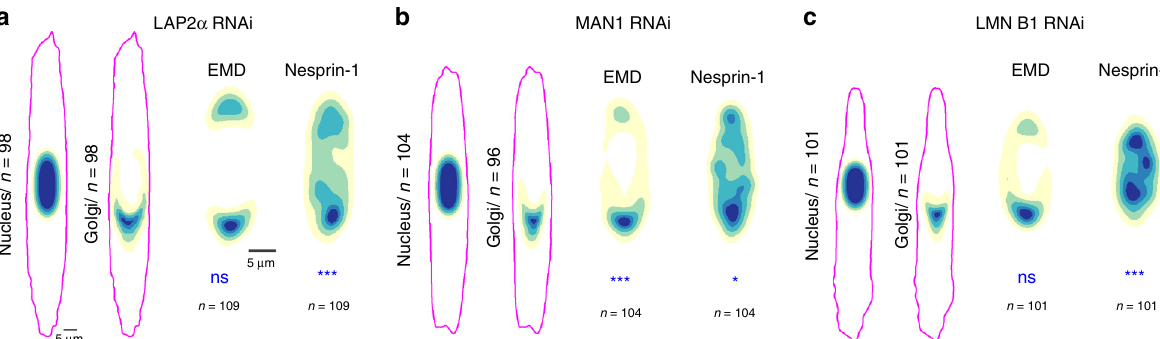
Fig. 3 Effect of LAP2 α , MAN1, and LMN B1 knock-down on nuclear polarity. a Distribution maps of the nucleus, Golgi, EMD and nesprin-1 in cells with LAP2 α knock-down. P Nesprin-1 = 0.0007, wo-sided Cramer-von Mises test. The magenta outline represents the F-actin border of the averaged cells. b Distribution maps of the nucleus, Golgi, EMD and nesprin-1 in cells with MAN1 knock-down. P EMD = 6.6 × 10 − 5 , P Nesprin-1 = 0.011, two-sided Cramer – von Mises test. The magenta outline represents the F-actin border of the averaged cells. c Distribution maps of the nucleus, Golgi, EMD and nesprin-1 in cells with LMN B1 knock-down. P Nesprin-1 = 1.96 × 10 − 7 , wo-sided Cramer – von Mises test. The magenta outline represents the F-actin border of the averaged cells. *** P < 0.001, ** P < 0.01, *P < 0.05, ns — not signi fi cant. For each distribution map an exact number of cells from three independent experiments is stated in the fi gure. Source data are provided as Source Data